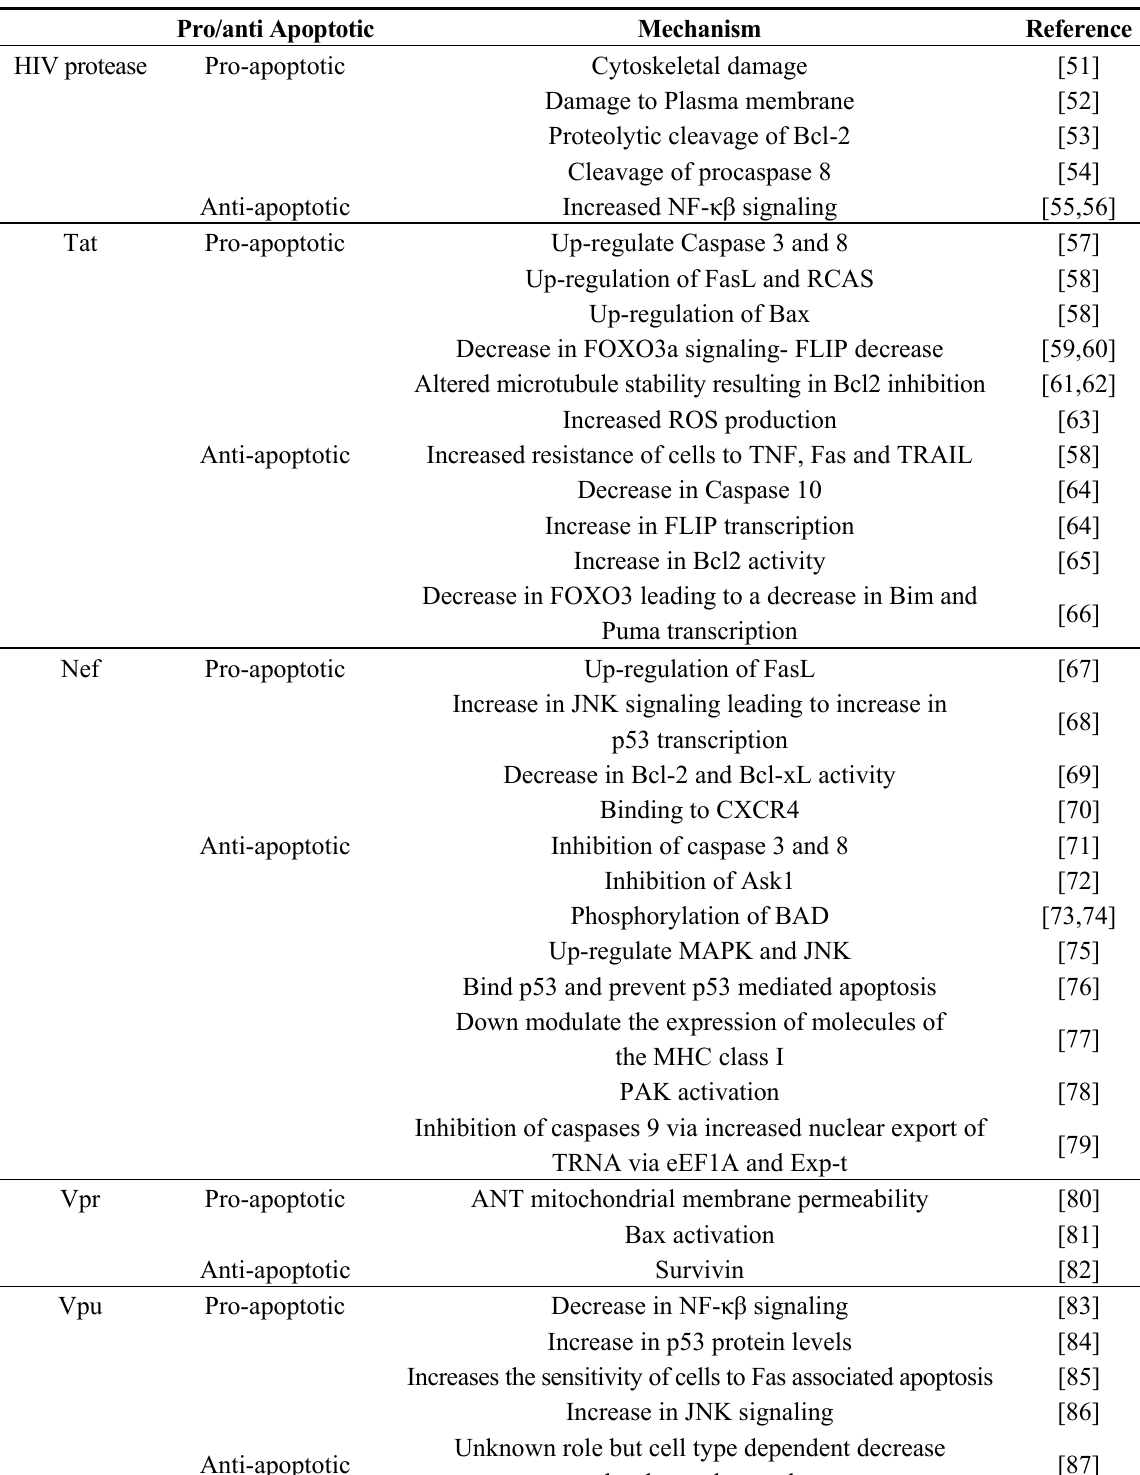
Table 1. Pro and Anti-apoptotic functions of HIV